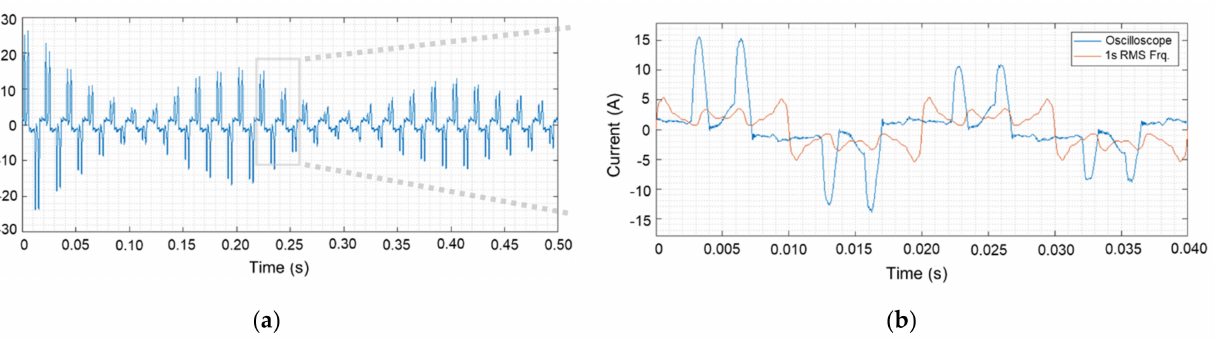
Figure 8. ( a ) Stacker Crane—Oscilloscope recording of the current waveform at the beginning of a translational operation of the stacker crane. ( b ) Current waveform from the oscilloscope record in comparison to the 1s RMS values to show the dependency of the resulting frequency spectrum in the data post